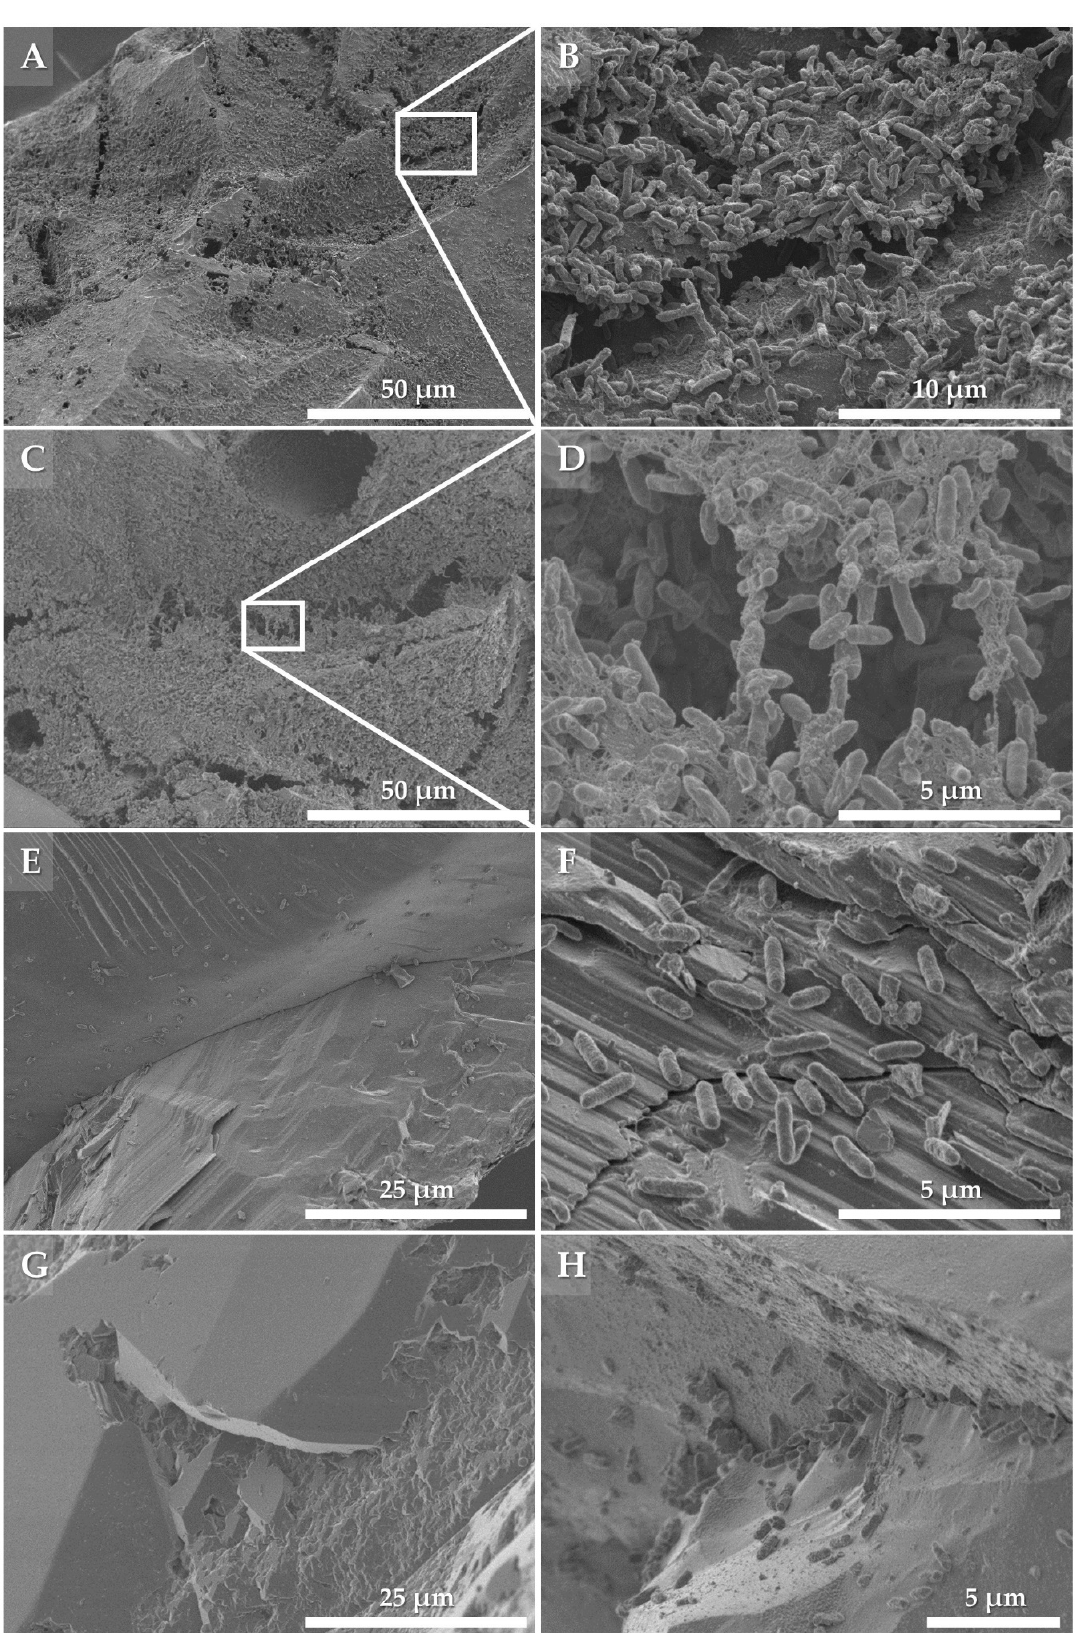
Figure 3. Characteristic scanning electron micrographs of ( A – D ) biofilm formed on pyrite grains as well as mostly uncolonised surfaces and few, generally scattered cells on chalcopyrite ( E , F ) and sand ( G , H ), demonstrating limited biofilm growth on these two substrates.